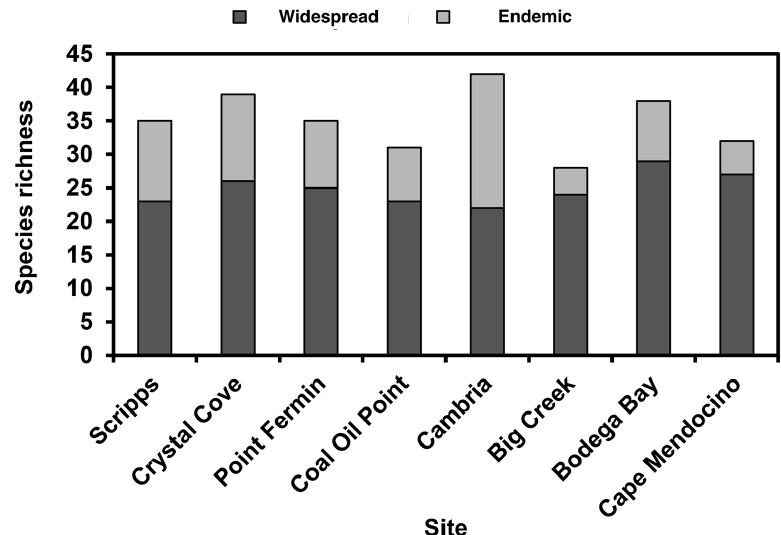
Figure 2. Diversity of narrow-range endemic and widespread species. Sites are listed latitudinally from south to north. The average (±SEM) of widespread richness was 25 (±1) species at all sites. Higher species richness (e.g., at Crytal Cove and Cambria) was primarily due to narrow-range endemic